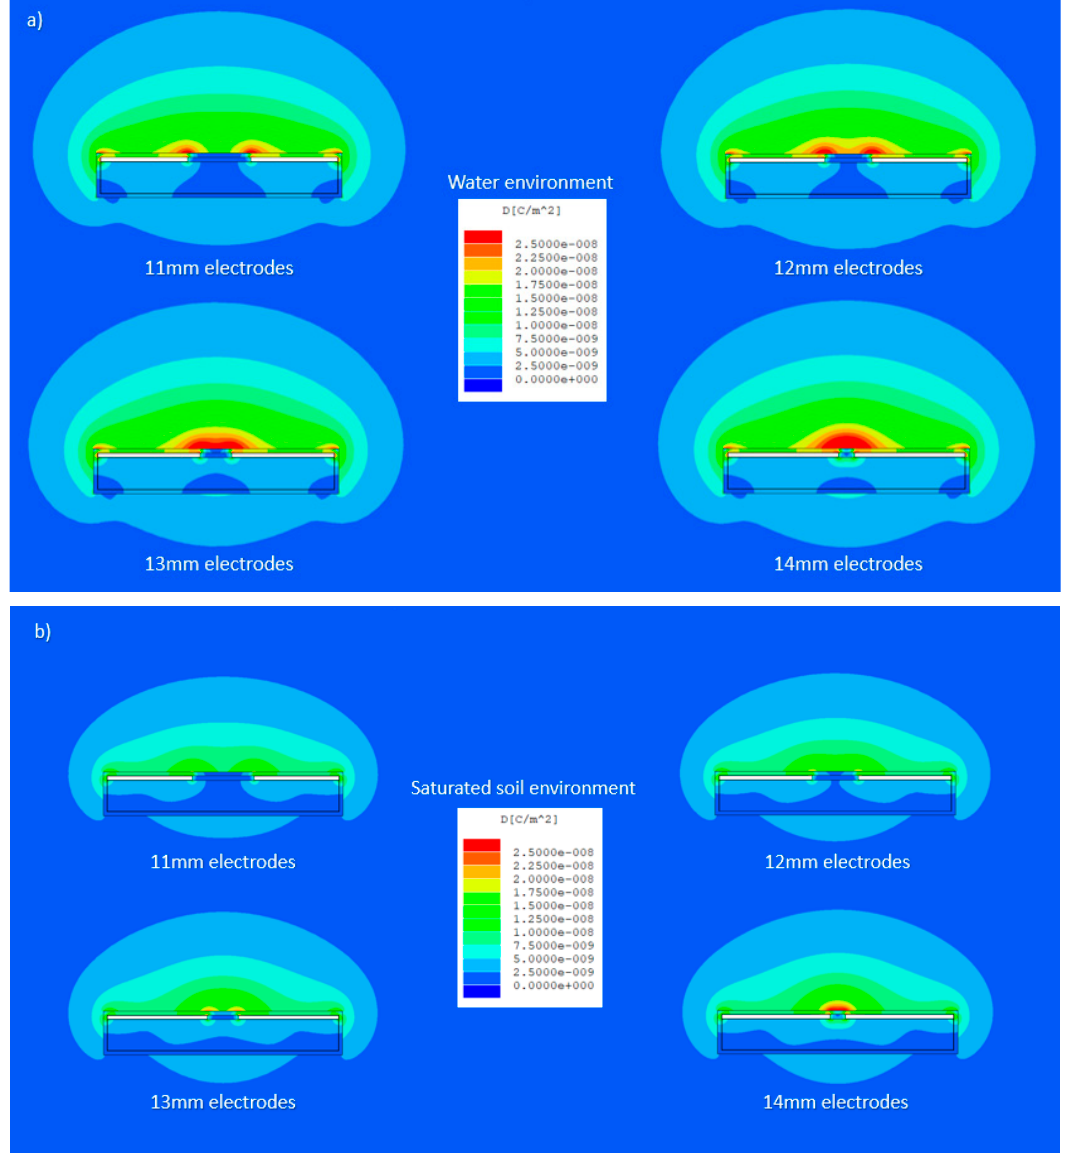
Figure 7. MagD and field penetration area obtained in ( a ) water, and ( b ) saturated soil conditions for various electrode lengths of 11 mm, 12 mm, 13 mm and 14 mm. In both simulated conditions, the maximum magD and field penetration are obtained for the electrode length of 14 mm.